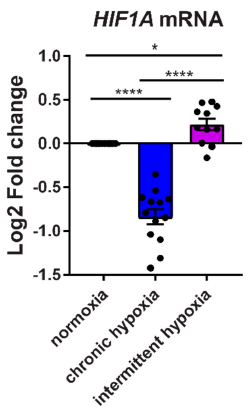
Figure 6. Expression of HIF1A transcription differs between chronic and intermittent hypoxia.